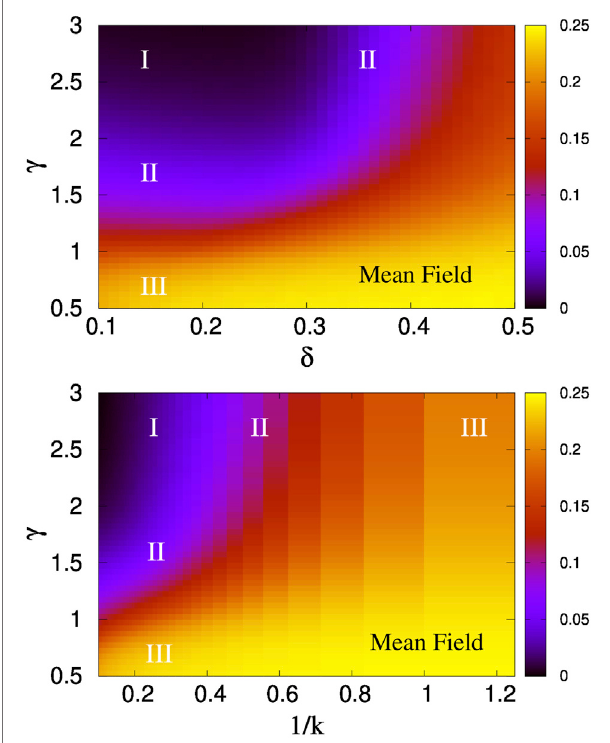
FIGURE 10 | Variation of ρ m for uniform (upper) and Weibull (lower) distribution when both the disorder strength ( δ or k ) and stress release range ( c ) is varied continuously. Three distinct regions (1) nucleation (2) avalanche and (3) percolation, is observed independent of the choice of threshold